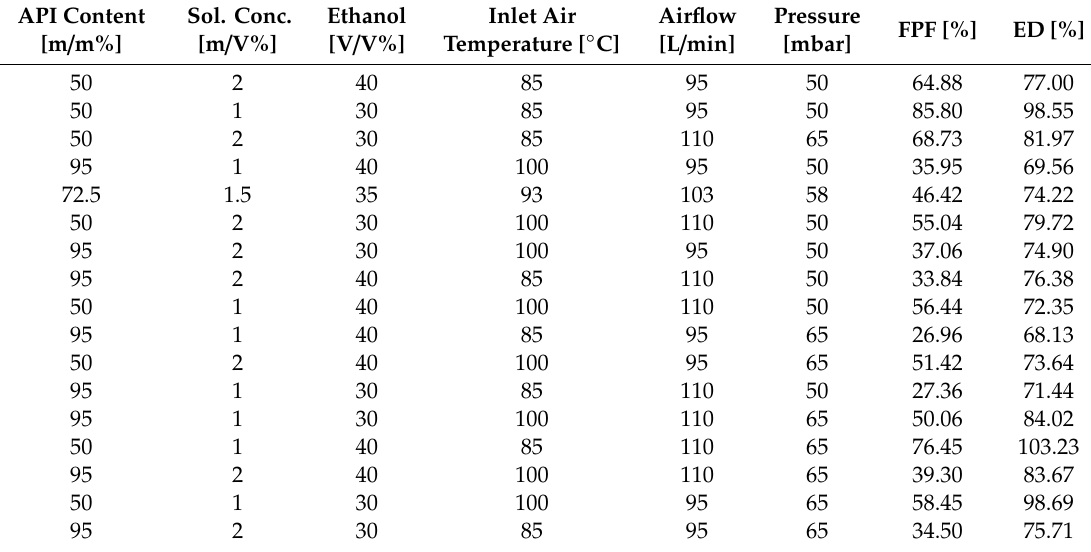
Table 1. Database applied in computational